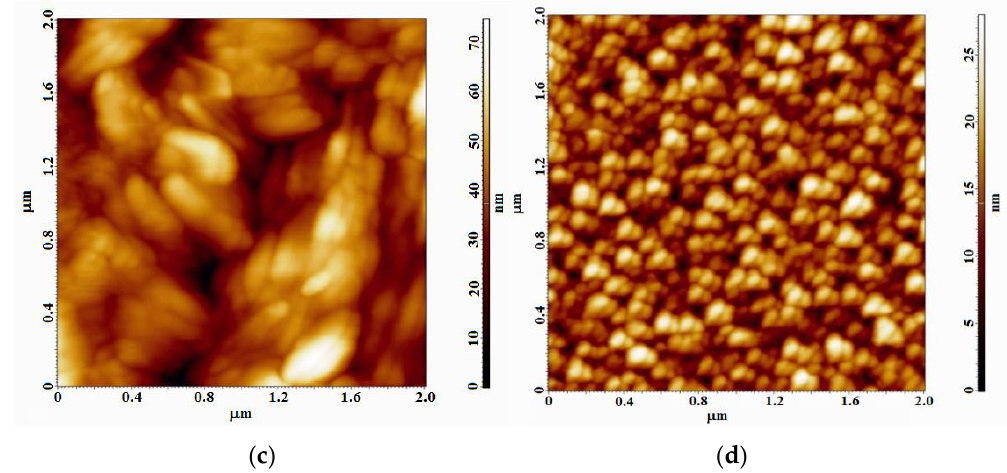
Figure 6. Atomic force microscopy images of ZnPcF 4 -np ( a ), ZnPcF 4 -p ( b ), ZnPcCl 4 -np ( c ), and ZnPcCl 4 -p ( d ) films.